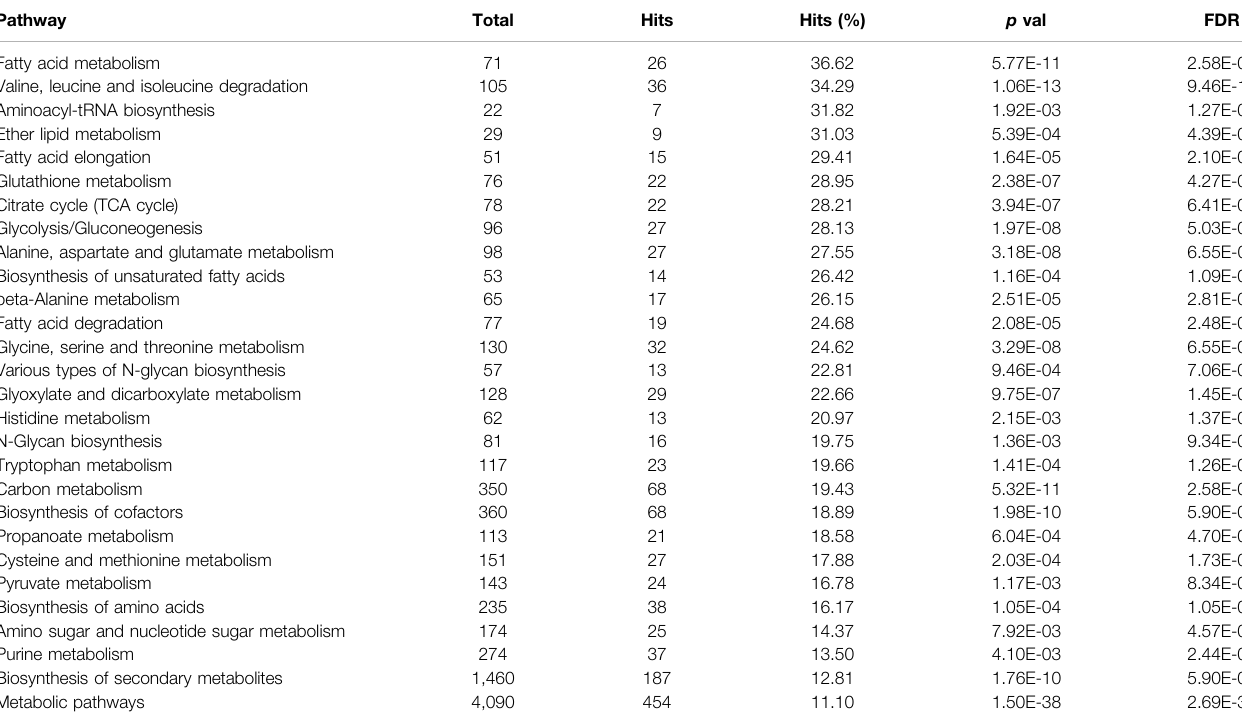
TABLE 2 | Main metabolic pathwaysidenti fi ed in trout liver asresults ofthe integrated metabolomic and proteomic joint pathway analysis. Pathways are ranked considering hits percentage (Hits%) and fi ltered taking False Discovery Rate (FDR) < 0.05 and Hits > 5 as minimum thresholds. Pathway Total Fatty acid